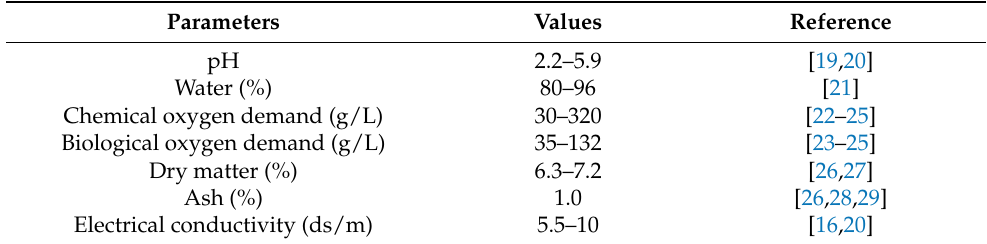
Table 1. Physicochemical characteristics of OMWW, adapted by Demerche et al. [6].